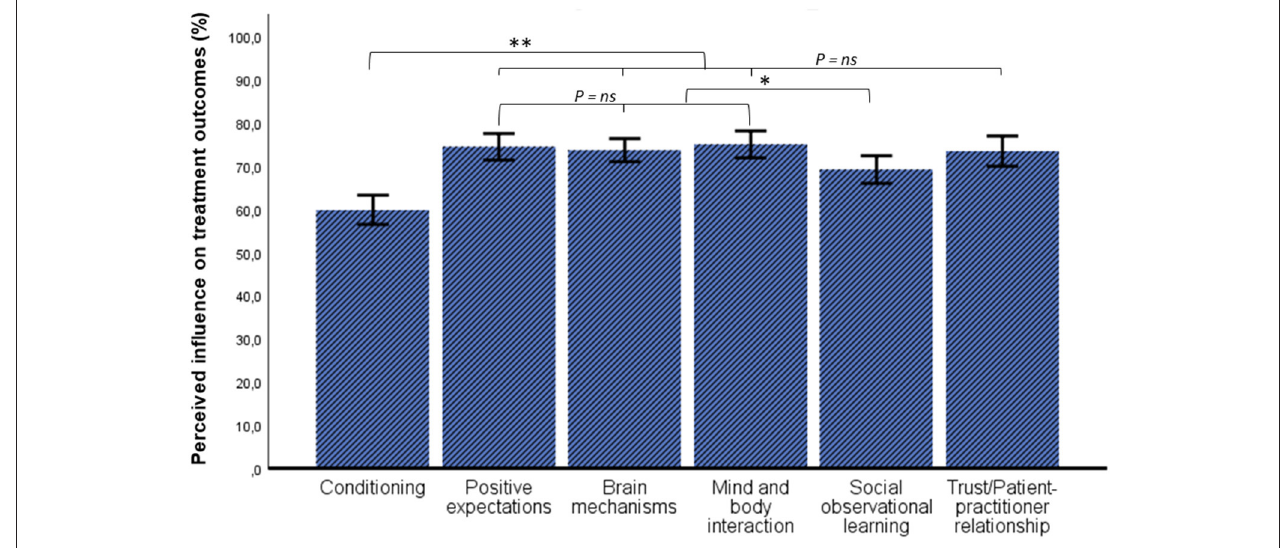
FIGURE 1 | Ratings of perceived influence of placebo factors in treatment outcomes. Error bars: 95% CI, * p < 0.05, ** p <